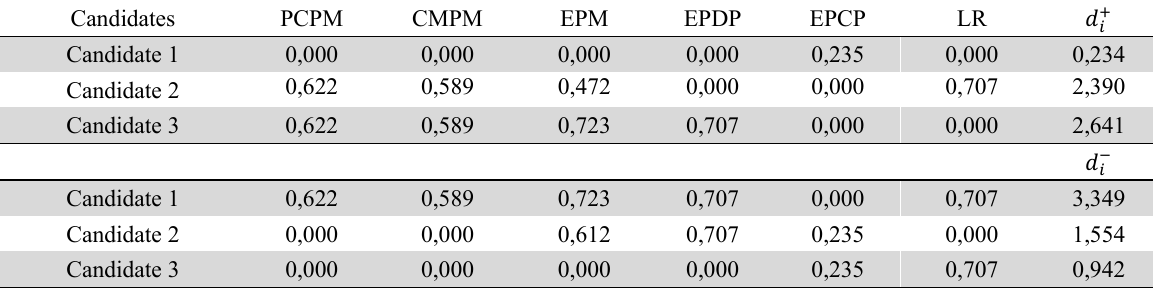
Distance of candidates to ideal alternatives